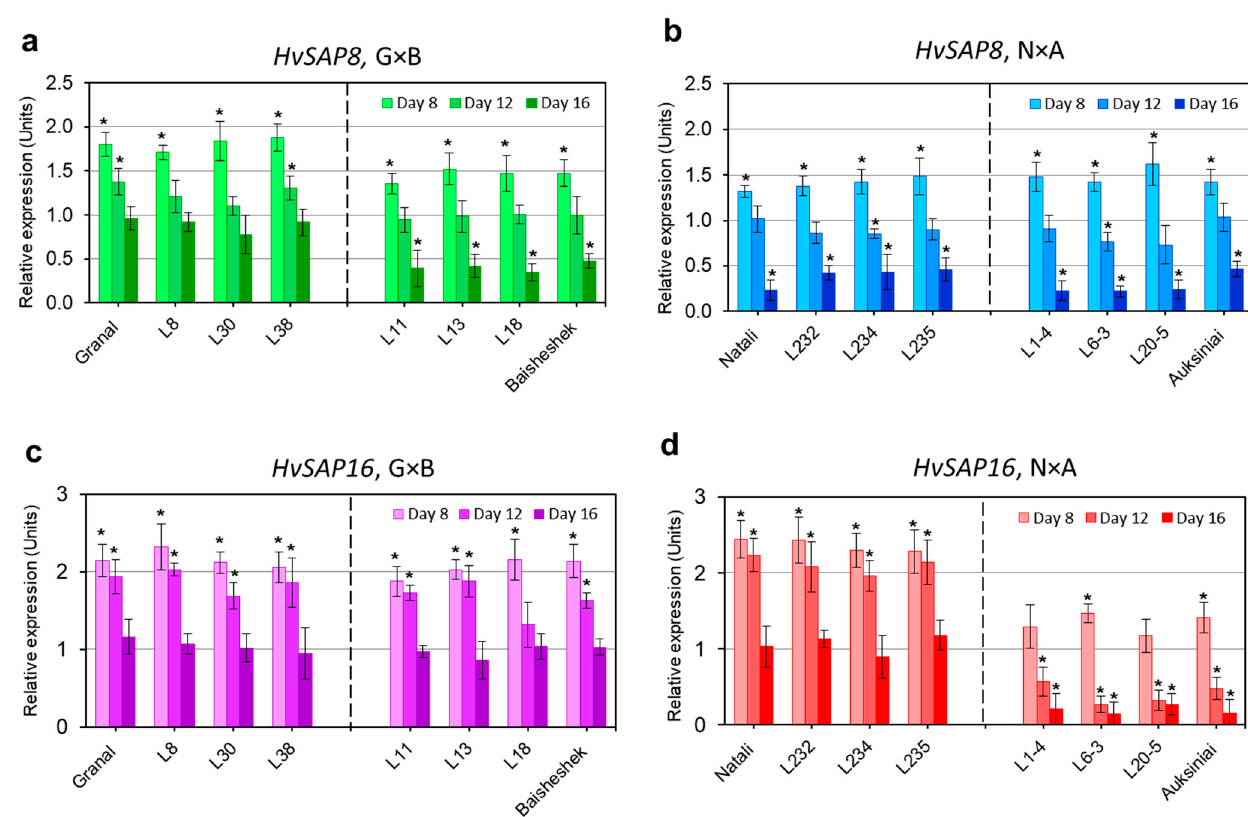
Figure 4. Expression analysis of HvSAP8 ( a , b ) and HvSAP16 ( c , d ) genes in two hybrid populations of barley, Granal × Baisheshek (G×B) ( a , c ), and in Natali × Auksiniai-2 (N×A) ( b , d ). Each experiment contains eight genotypes including both parents and six breeding lines of each hybrid population. Three breeding lines were selected by SNP genotypes identical to each parent and are separated by a dashed line in the figure panels. Leaf samples were collected from soil-grown plants at four consecutive time-points, where Relative expression at ‘day 0 ′ (well-watered Controls) was set as unit level 1 for all genotypes and experiments. Three collection time-points were at day 8, 12 and 16, from when water was withdrawn, corresponding to mild, moderate and strong drought treatment, respectively. Expression data were normalised using two Reference genes, HvADP (ADP-ribosylation factor 1-like protein) and HvGAPD (Glycolytic glyceraldehyde-3-phosphate dehydrogenase), and are presented as the average ± SE of three biological replicates (individual plants) and two technical repeats for each genotype and treatment. Significant differences ( p < 0.05) from relative level 1 are designated by asterisks (*) above the bars, for each genotype and experiment, calculated using ANOVA.